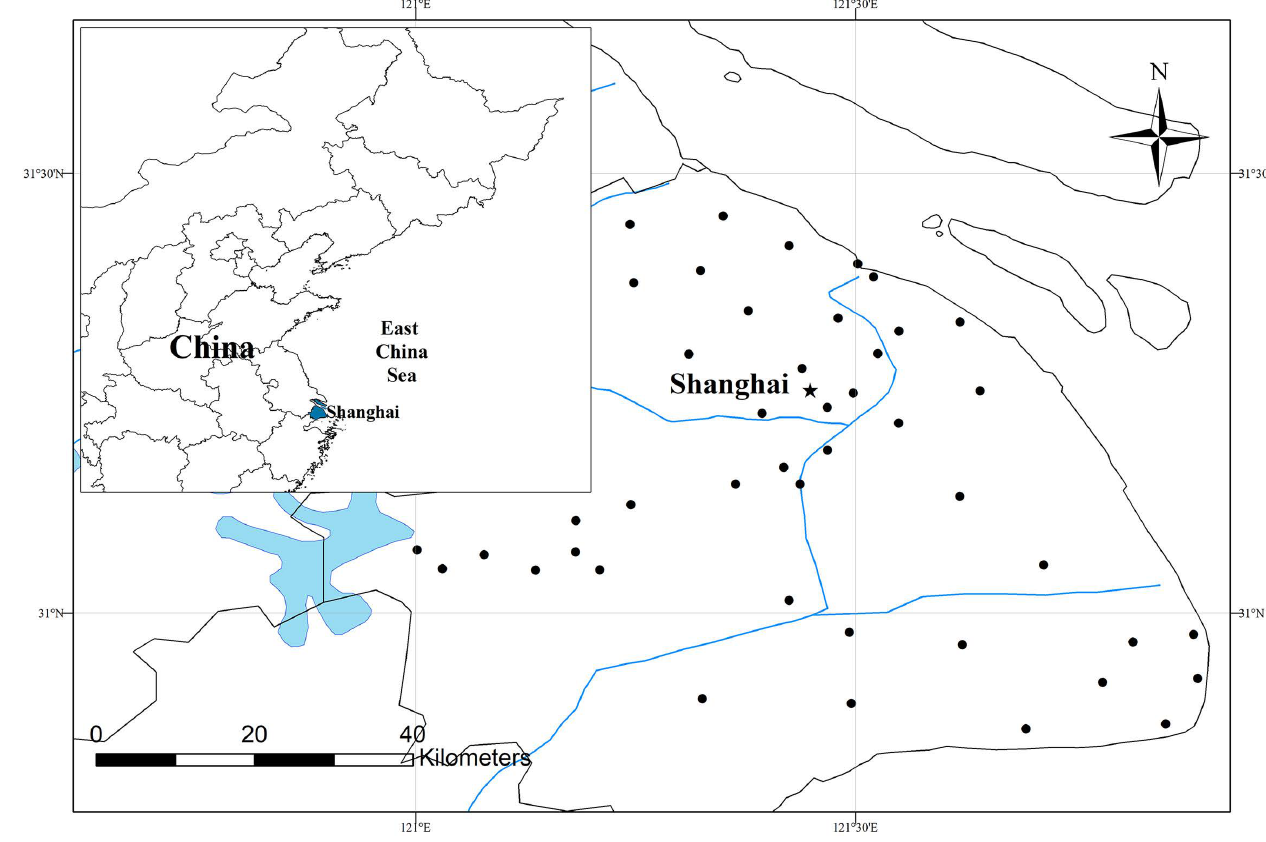
Figure 1. Map of the study area in Shanghai. Solid dots indicate the location of 44 survey wetlands. Map shows the major rivers and lakes near the study sites in